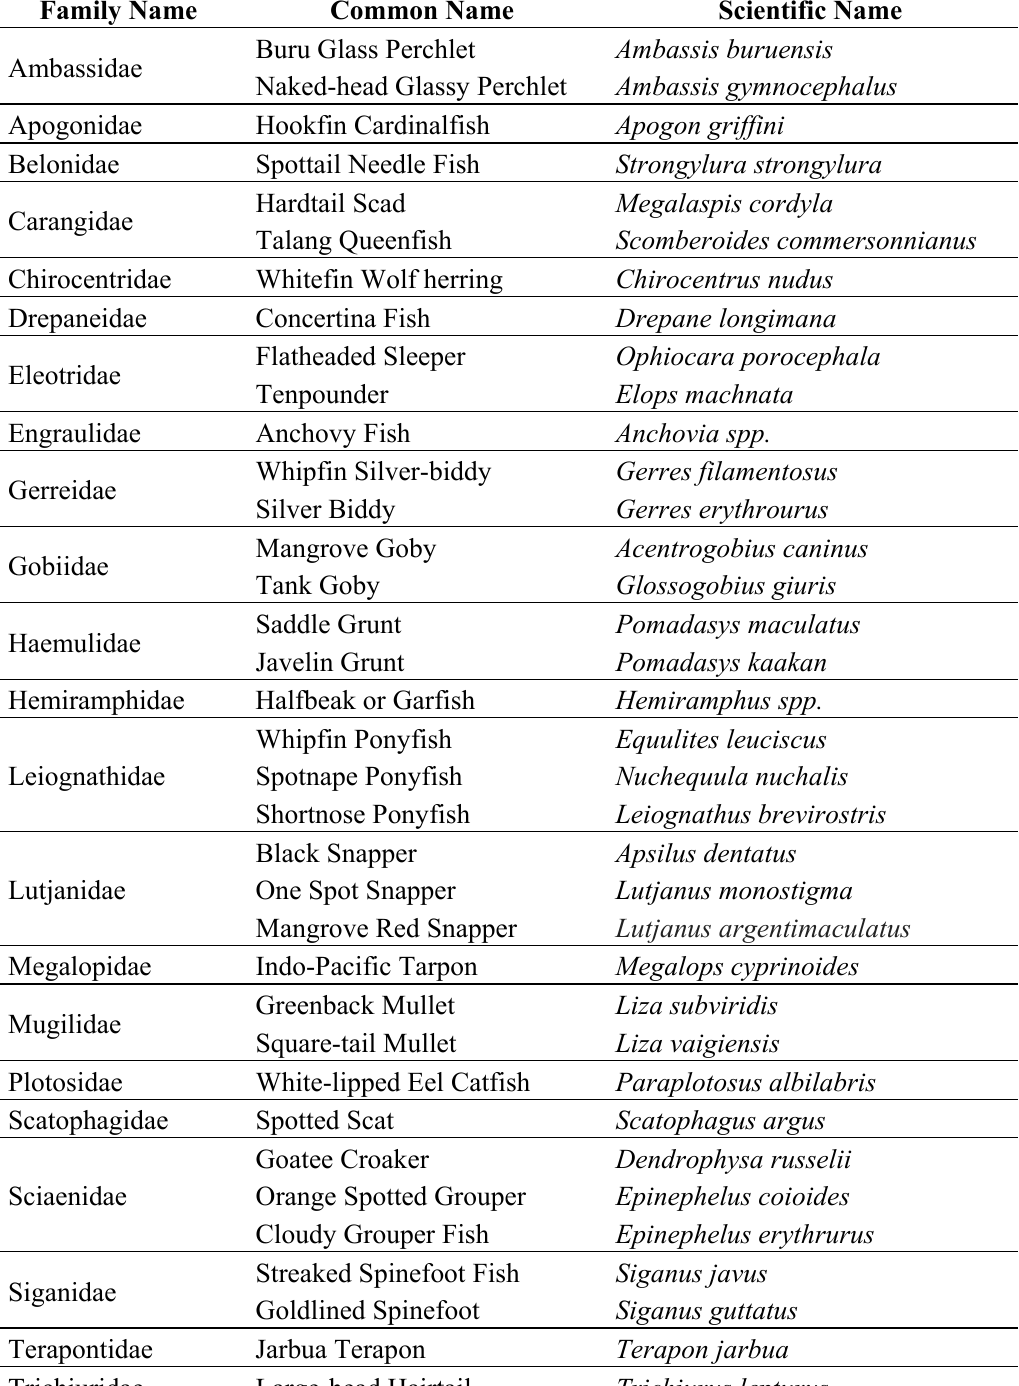
Table 2. List of fish species captured in Marudu Bay mangrove and river